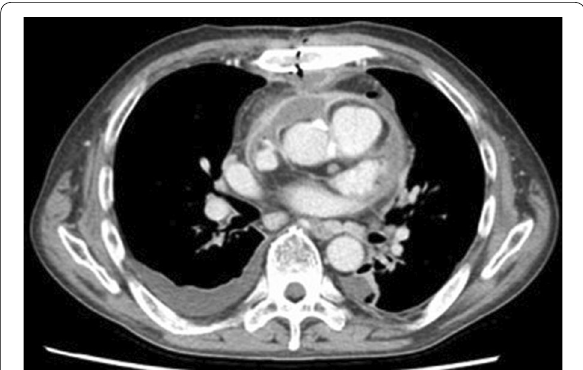
Fig. 1 Computed tomography showing retrosternal fluid and free air, indicating mediastinitis